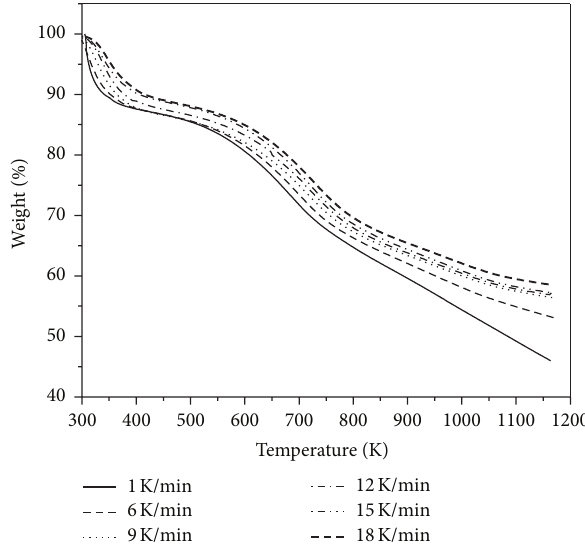
Figure 1: Thermal behavior of Poplar coal at different heating rates under N 2 atmosphere.